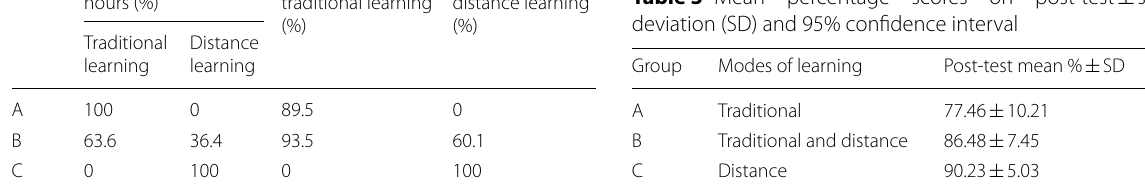
Table 1 Attendance rate of traditional (on-campus sessions) and distance learning (online synchronous sessions) Group Scheduled contact hours (%) Table 3 Mean percentage scores on post-test ±